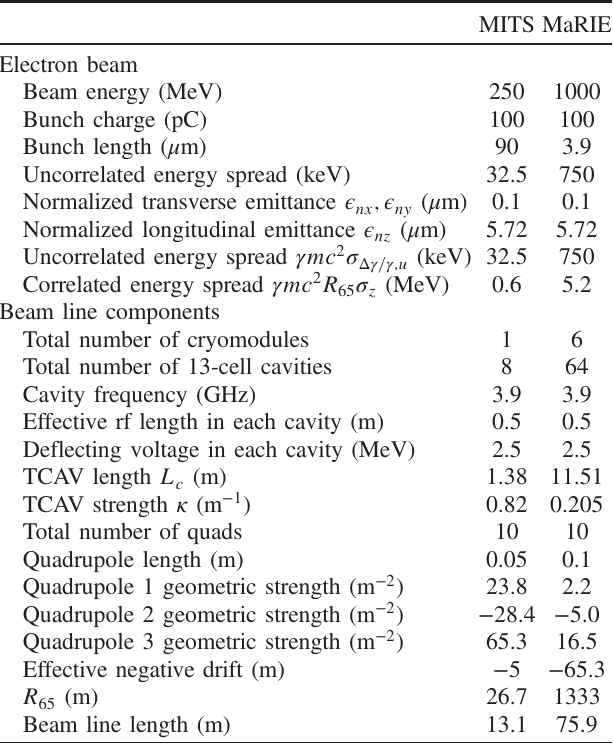
TABLE II. Parameters of the TCAV-based dechirper beam line and beam for MITS.